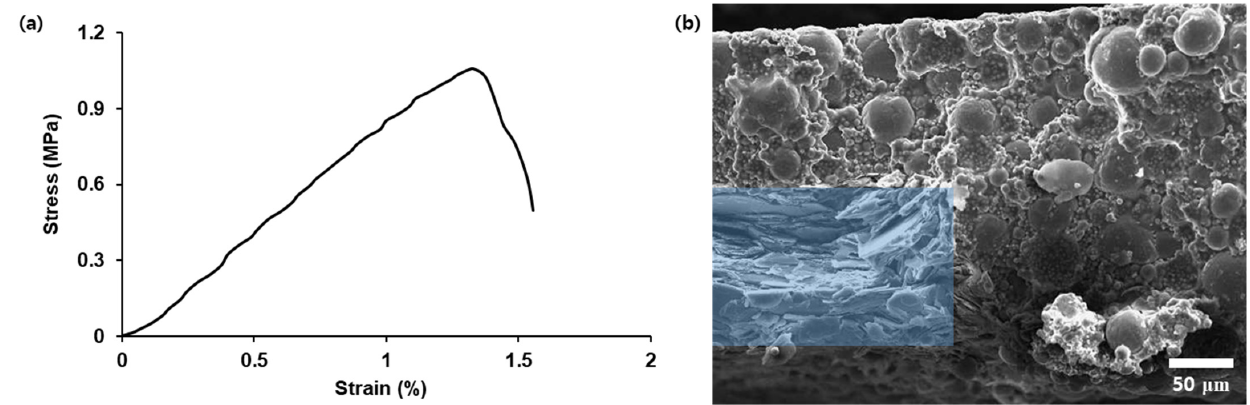
Figure 8. ( a ) Stress–strain curve of the Al/h-BN/Al-1 composite and ( b ) SEM image of the torn sur- face of the Al/h-BN/Al-1 composite after a tensile test. The blue area represents the stack of the aligned h-BN fillers in the composite.